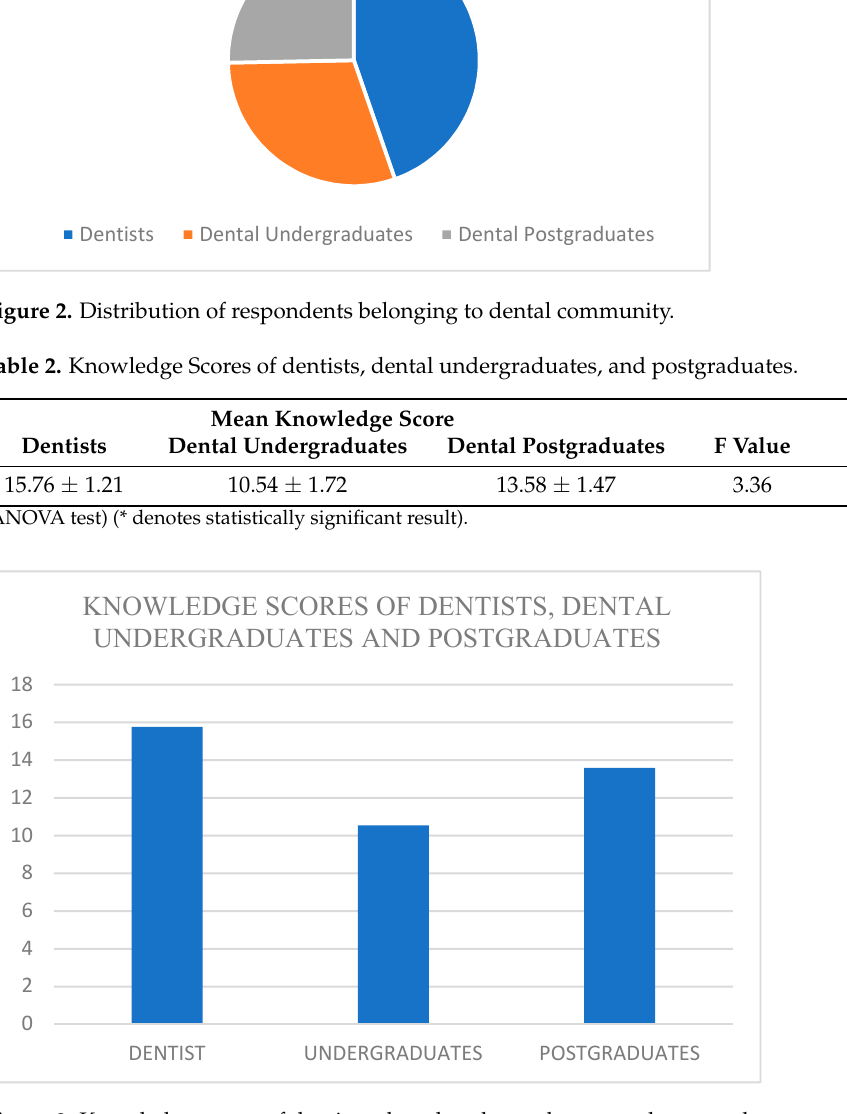
Figure 2. Distribution of respondents belonging to dental community.